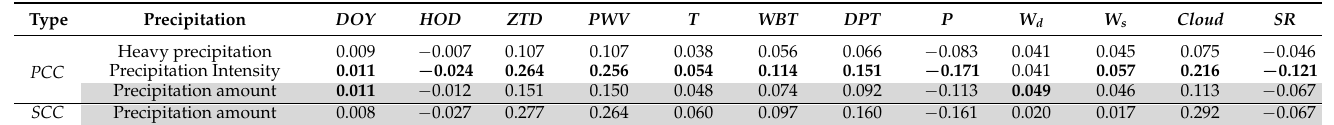
Table 3. Pearson and Spearman’s rank correlation coefficient results by comparing each of the twelve variables with precipitation records over the period